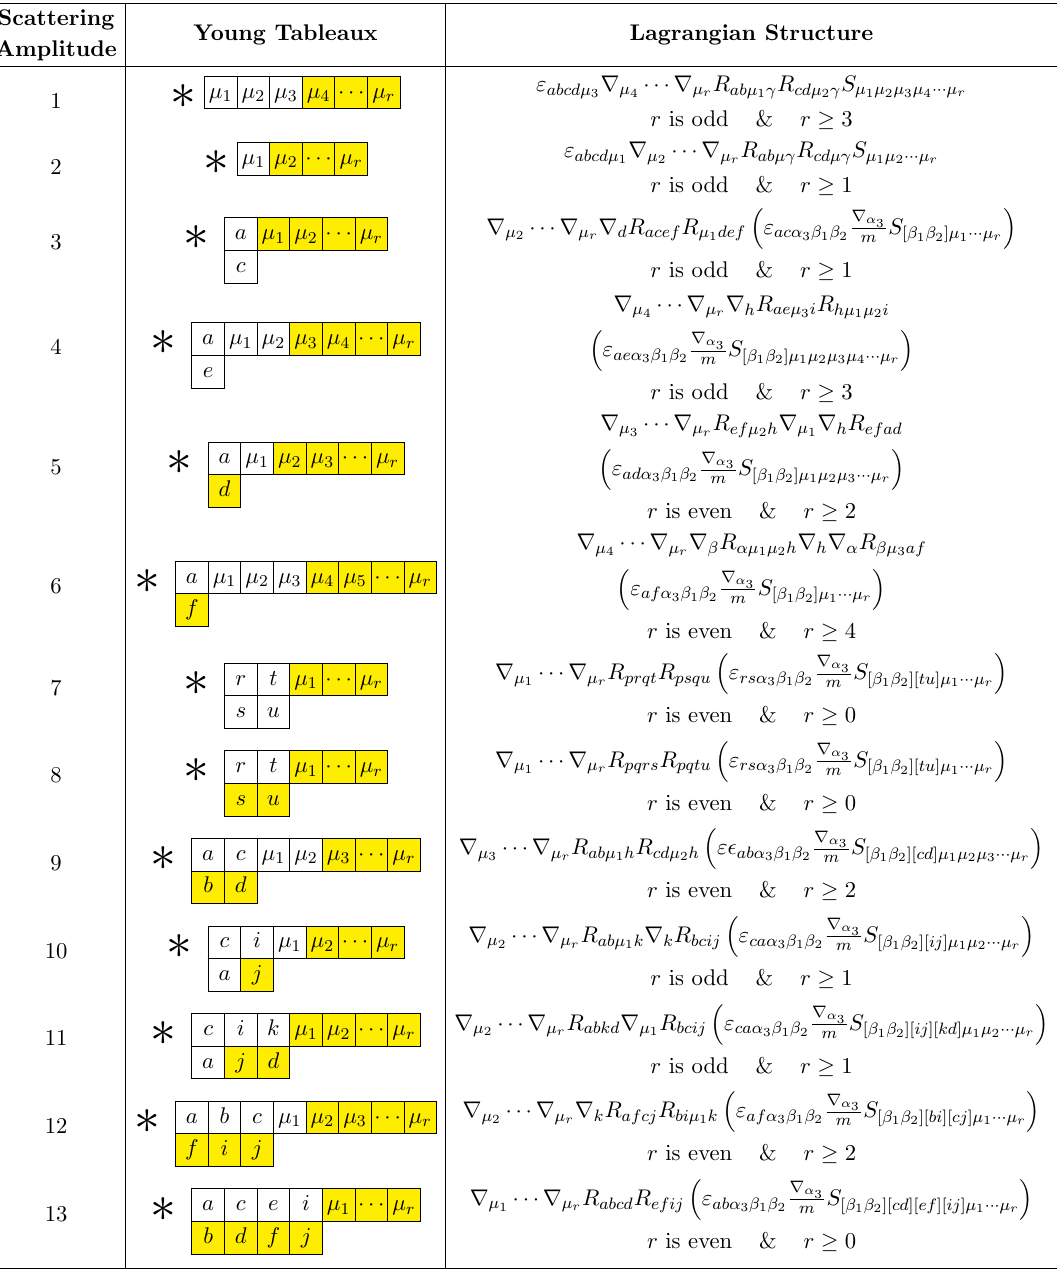
(cid:3) was explained in the caption to table 3.